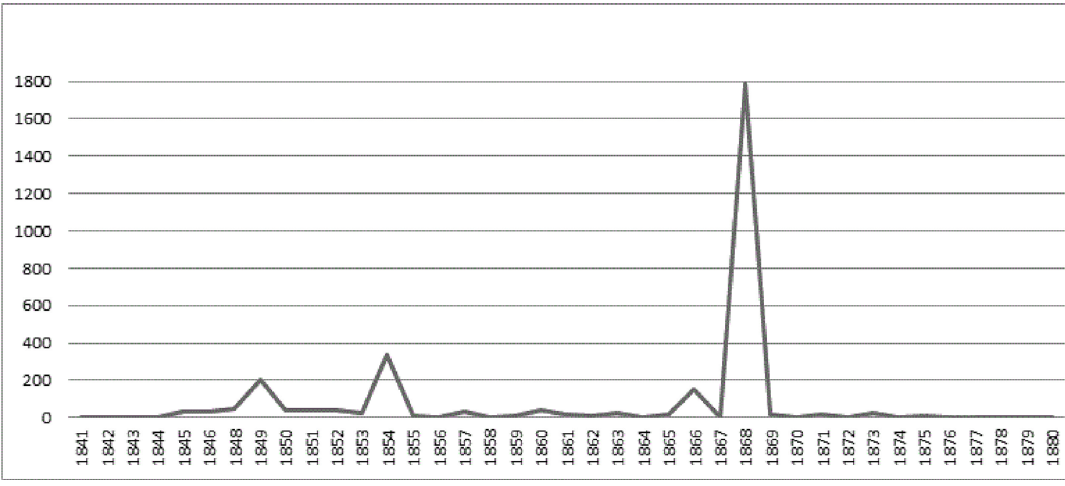
Figure 4: Place-name collocations of the word ‘cholera’ by year. Minor and major cholera events were identified (epidemics of 1849, 1854 and 1866) as well as the creation of Farr’s dedicated volume to the disease published in